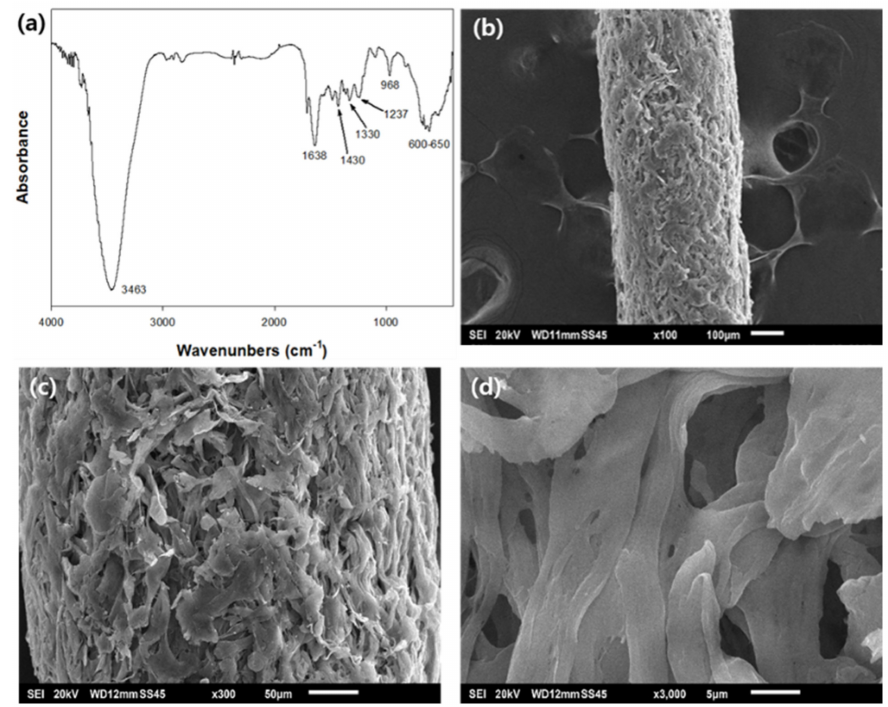
Figure 2. Fourier transform infrared spectroscopy (FTIR) spectrum of PEI/PVC-CF ( a ) and scanning electron microscopy (SEM) images of PEI/PVC-CF at 100 × ( b ), 300 × ( c ), and 3000 × ( d ) magnifica- tions. (SEI: Secondary Electron Image; the SEM images were recorded at 20 kV, the units in Figure ( b – d ) were 100, 50, and 5 µ m,